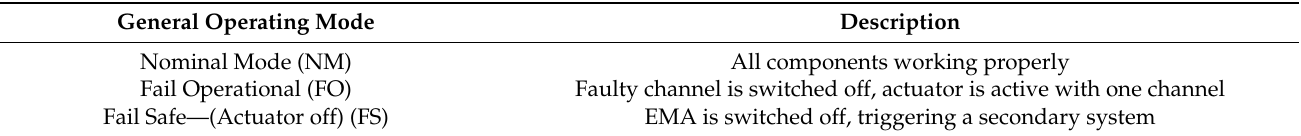
Table 1. EMA operating modes.